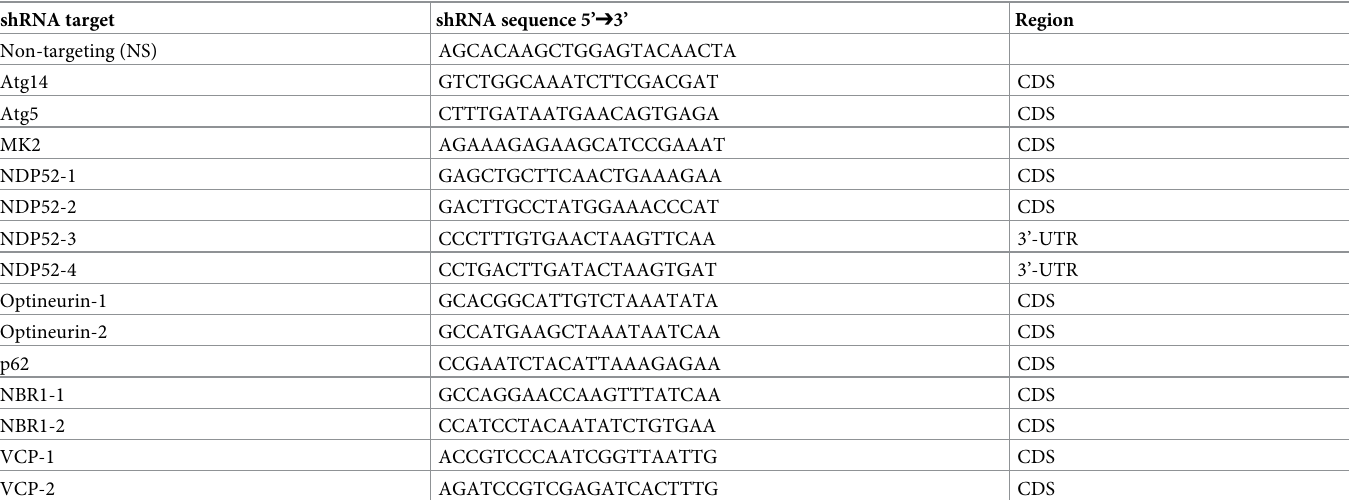
Table 3. shRNA target sequences.